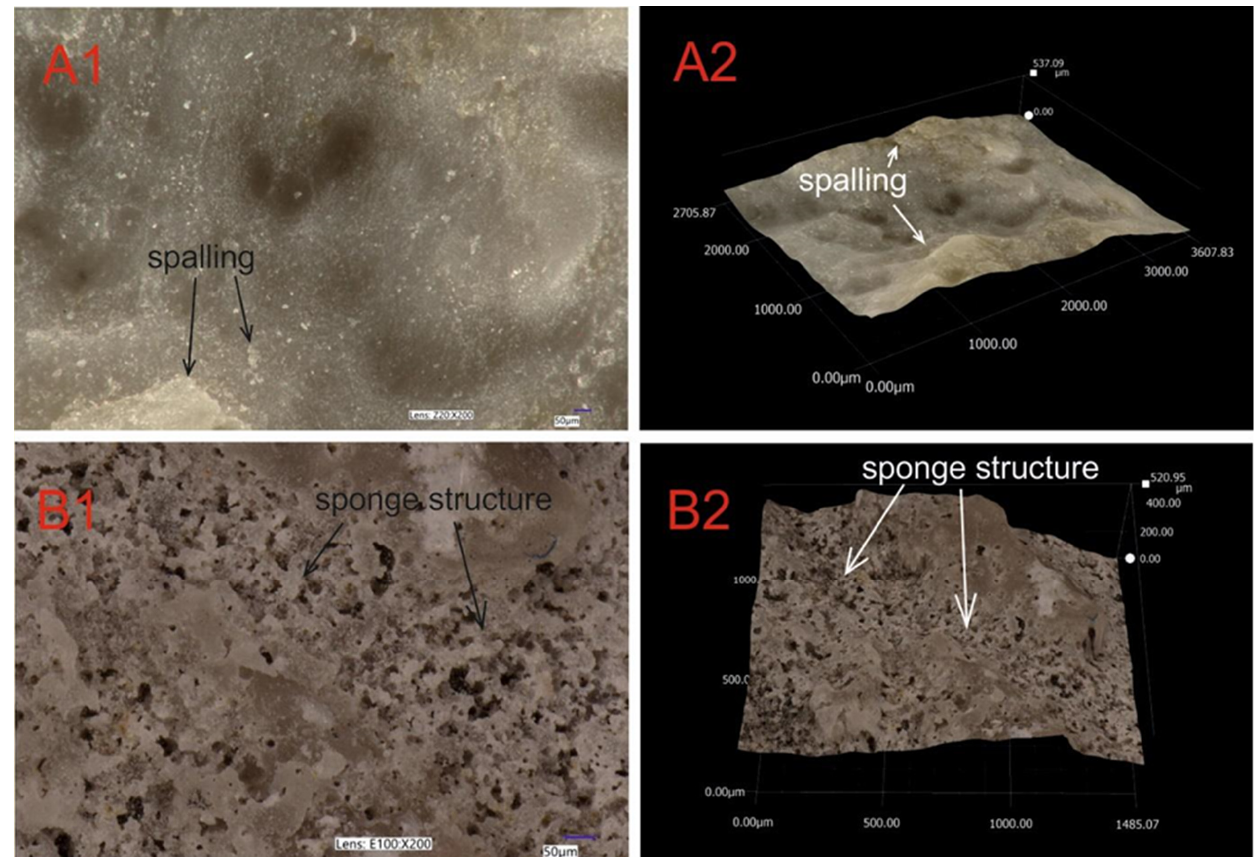
Figure 10. Images of the rock surface from site 1 ( A1 , A2 ) and site 5 ( B1 , B2 ) obtained under the Keyence Digital Microscope. Note that sponge structures develop mostly in concave parts of the rock surface ( B2 ).